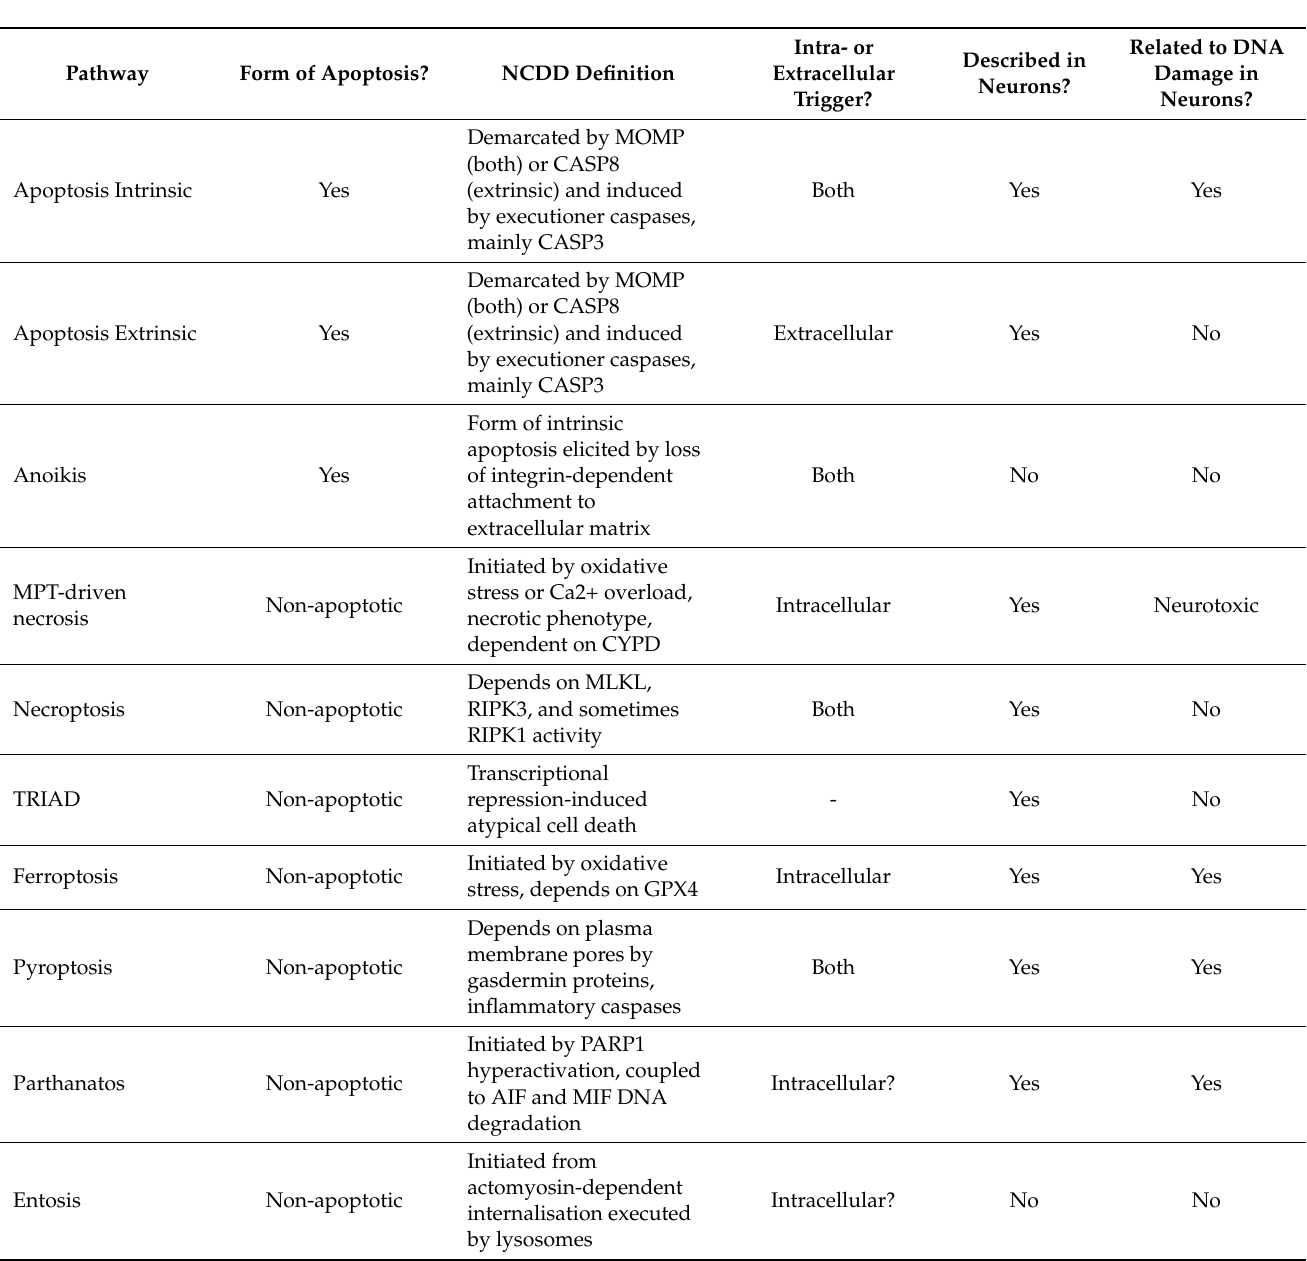
Table 1. Classification of regulated cell death (RCD) mechanisms. Cells exposed to perturbations of the intracellular/extracellular environment activate various signalling pathways that lead to distinct types of RCD. These types are categorised by the NCDD based on their molecular and cellular